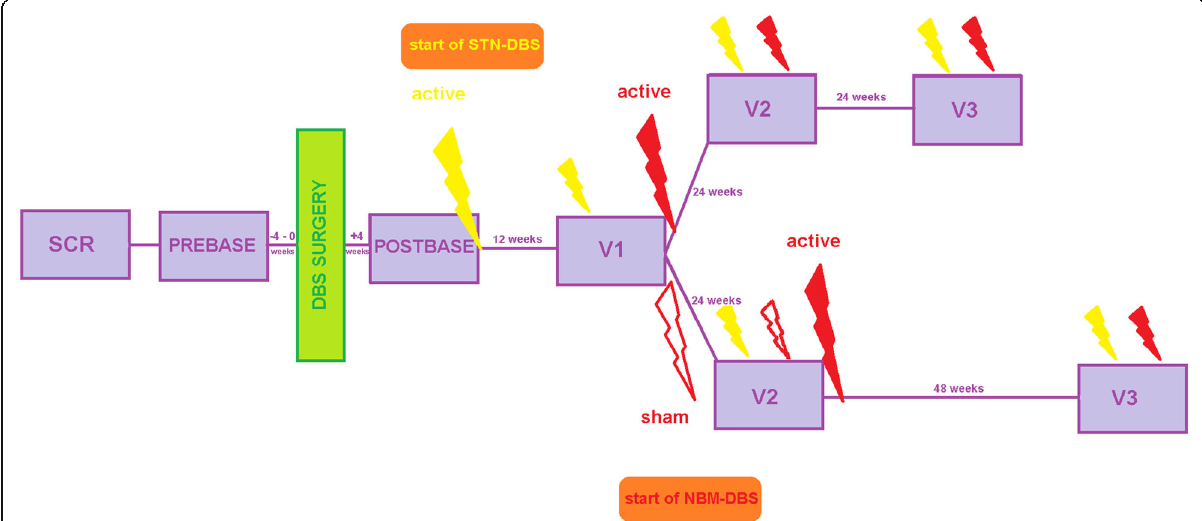
Fig. 1 Visit schedule of DEMPARK-DBS: Icon “ flash ” = ‘ activation ’ or ‘ active ’ DBS. PREBASE, presurgical baseline visit; POSTBASE, postsurgical baseline visit; SCR, screening visit; V1, Visit 1; V2, Visit 2; V3, Visit 3